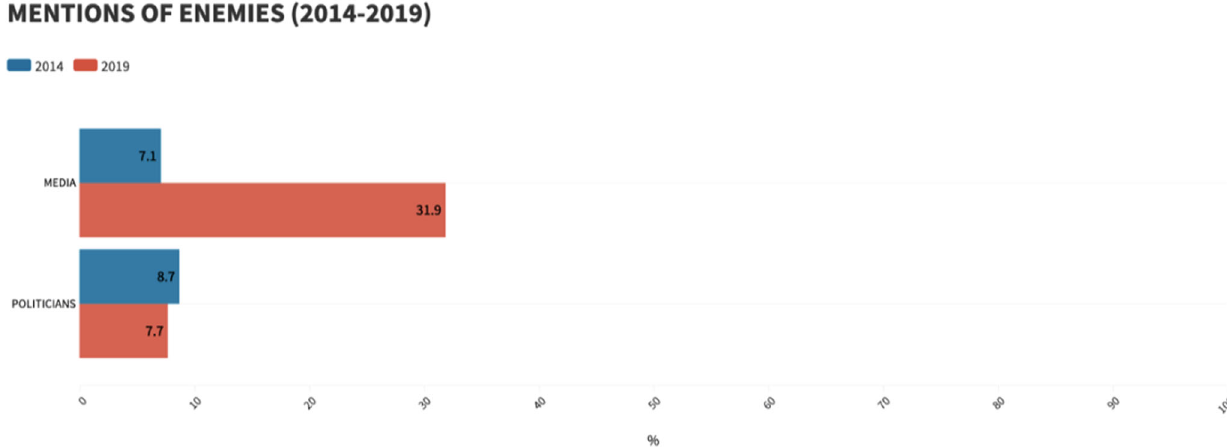
Fig. 6 Evolution in the mentions of enemies (2014 –